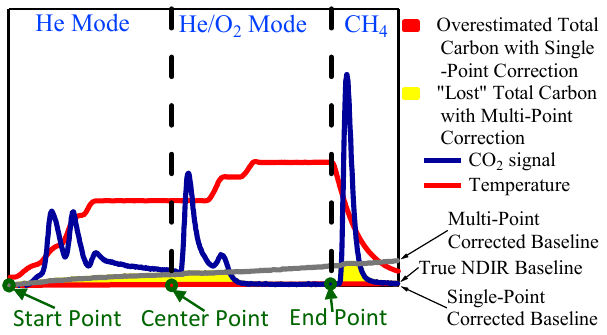
Figure 2. Schematic diagram of the suspected mechanism of the calculation discrepancy produced by the multipoint baseline correction method.